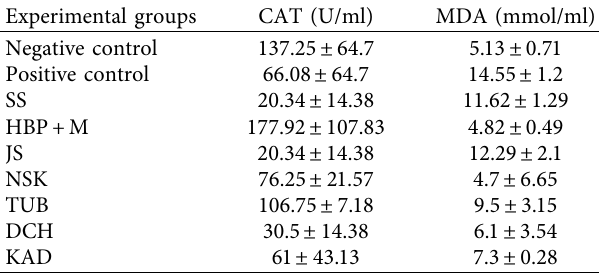
Table 5: Summary of oxidant and antioxidant